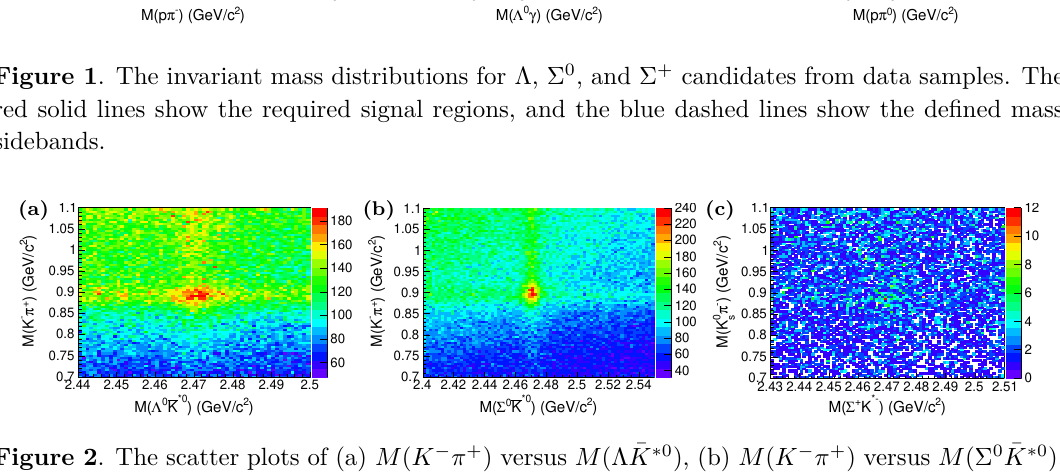
Figure 2 . The scatter plots of (a) M ( K − π + ) versus M (Λ ¯ K ∗ 0 ) , (b) M ( K − π + ) versus M (Σ 0 ¯ K ∗ 0 ) , and (c) M ( K 0 π − ) versus M (Σ + K ∗− ) distributions from data S